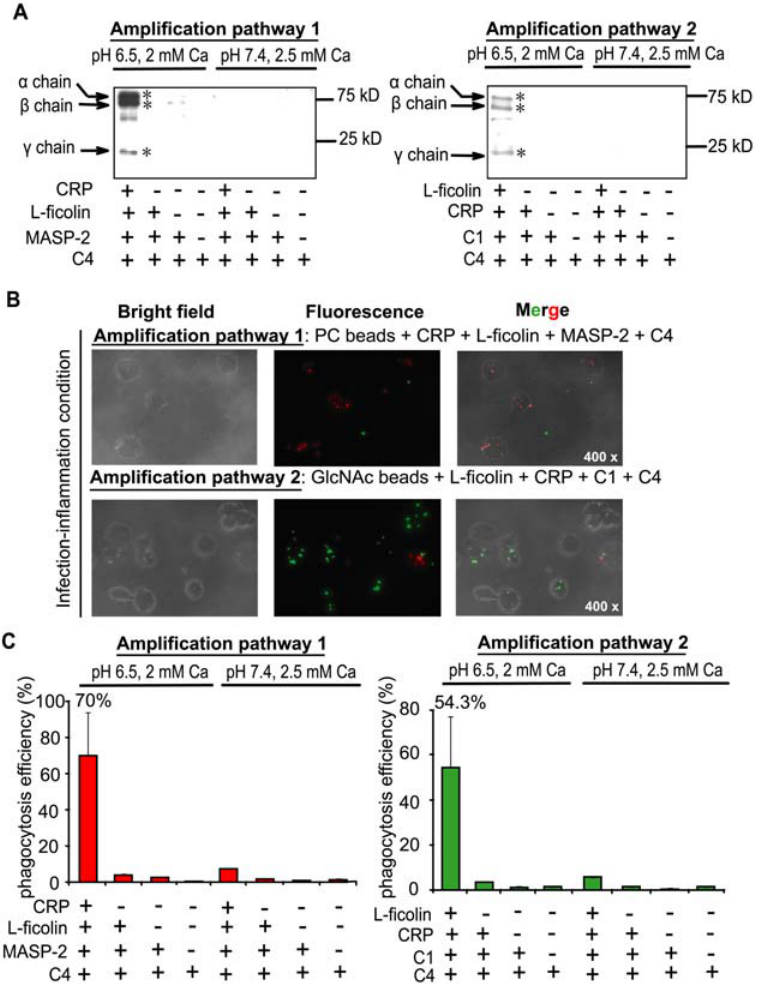
Figure 3. Downstream functional analysis of amplification pathways 1 and 2 by C4 cleavage assay and phagocytosis assay. (A) C4 cleavage assay with PC and GlcNAc as ligands in normal (pH 7.4, 2.5 mM calcium) and infection-inflammation (pH 6.5, 2 mM calcium) conditions. PC beads were incubated with amplification pathway 1 components (CRP, L-ficolin, MASP-2, or C4) and GlcNAc beads were incubated with amplification pathway 2 components (L-ficolin, CRP, C1, or C4) under normal and infection-inflammation conditions. The cleaved C4 deposited on the beads were detected by Western blot. Negative controls were beads incubated with complete amplification components under normal condition, and incomplete amplification pathway components under normal or infection-inflammation conditions. * indicates the C4 cleavage products. (B) The phagocytosis assay of the opsonized beads generated in amplification pathways 1 and 2 under infection-inflammation condition (magnification: 400 6 ). The fluorospheres with PC-BSA (red) or GlcNAc-BSA (green) immobilized on the surface were opsonized by incubating with complete or partial components of the amplification pathway as indicated in the C4 cleavage assay (under infection-inflammation condition). These beads (red or green) were mixed with equal amounts of control beads (green or red) which have BSA immobilized on their surfaces without PC- or GlcNAc-residues. The mixture (opsonized beads:control beads:U937 cells) at a ratio of 15:15:1 was incubated at 37 u C for 30 min with gentle shaking. Cells fixed in 4% paraformaldehyde were visualized under fluorescence microscope. (C) Quantification of the phagocytic efficiency observed under the microscope. Three different fields were chosen for each sample and the average net number of opsonized beads (number of opsonized beads 2 number of control beads) in each cell in each field was enumerated and calculated. A count of 15 beads in each cell was considered 100% phagocytic